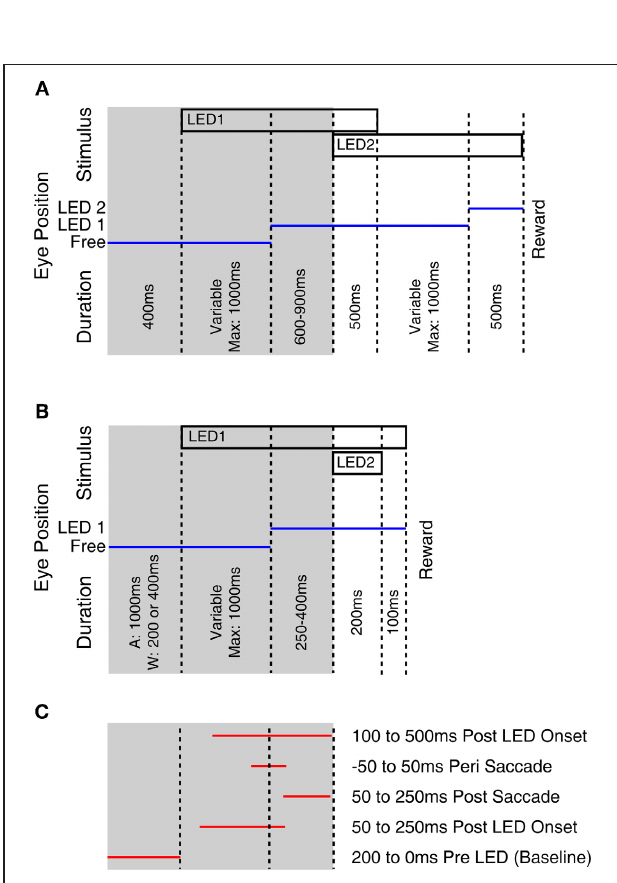
FIGURE 1 | Fixation tasks used to probe for visual responses. This figure illustrates the behavioral tasks used to probe for visual stimuli. Monkeys E and M performed a multiple fixation task (A) whereas monkeys A and W held fixation while ignoring a probe stimulus (B) . Temporal intervals tested for visual modulation of activity (C) used only the first part of the trials, that was common across monkeys. The tested epochs indicated in (C) are not drawn to scale as trials involved variable time